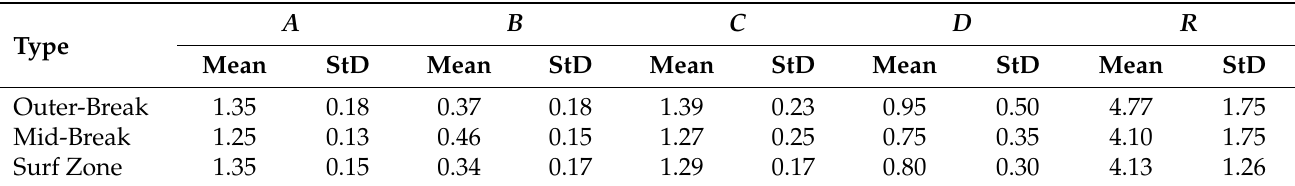
Table 4. Mean and standard deviation for the five characteristic points defining the wave signature for impacts by spilling breakers in varying depths. Points A through D have units of acceleration/g, while the R column is the maximum magnitude of pitch and roll rotational rate recorded during the breaking event having units of